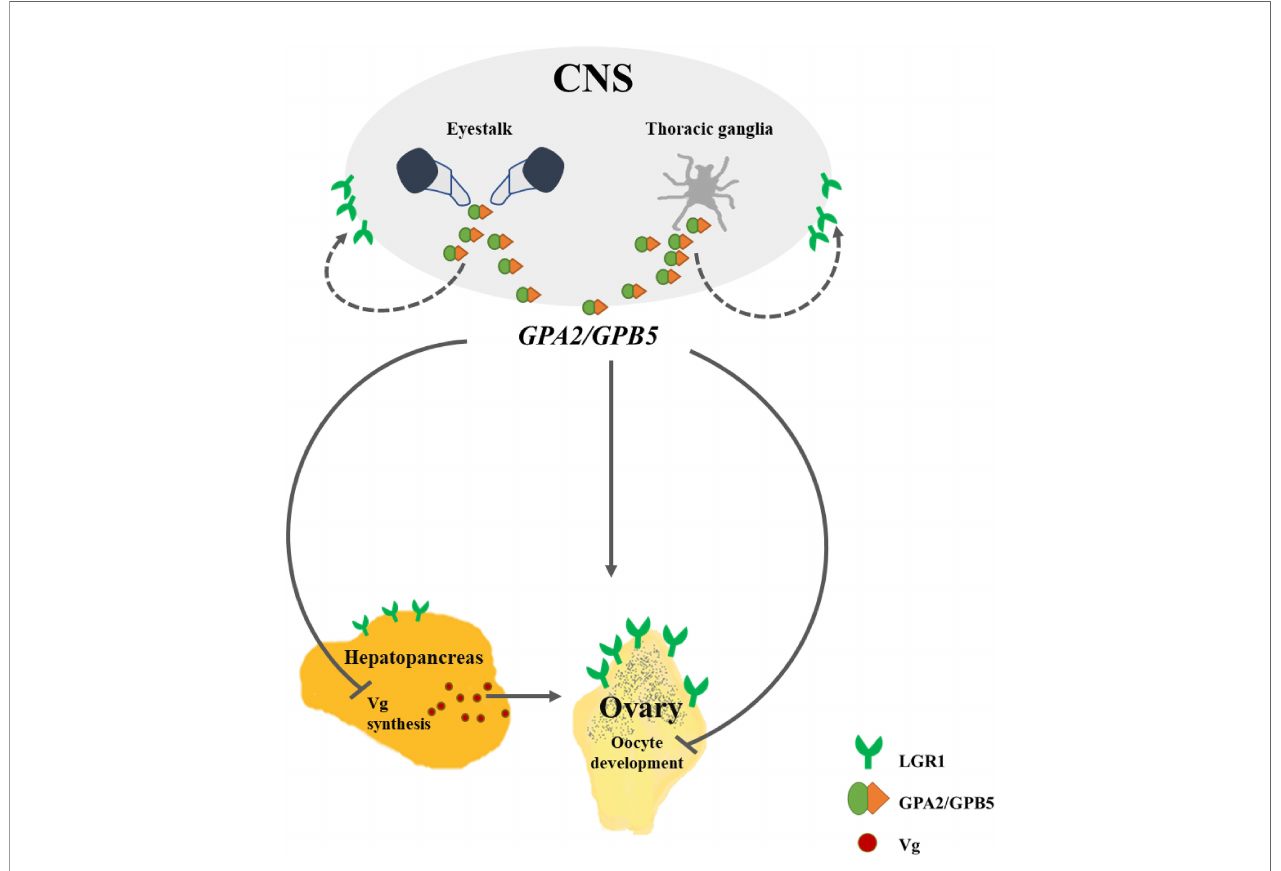
FIGURE 9 | Putative model of the GPA2/GPB5 and LGR1 pathways in M. rosenbergii females. LGR1, leucine-rich repeat-containing G protein-coupled receptor 1; GPA2, glycoprotein alpha 2; GPB5, glycoprotein beta 5; Vg, vitellogenin; CNS, central nervous system. Solid arrows indicate known interactions; dashed arrows, possible interactions; lines with arrowheads, stimulatory effect; lines with blunted ends, inhibitory